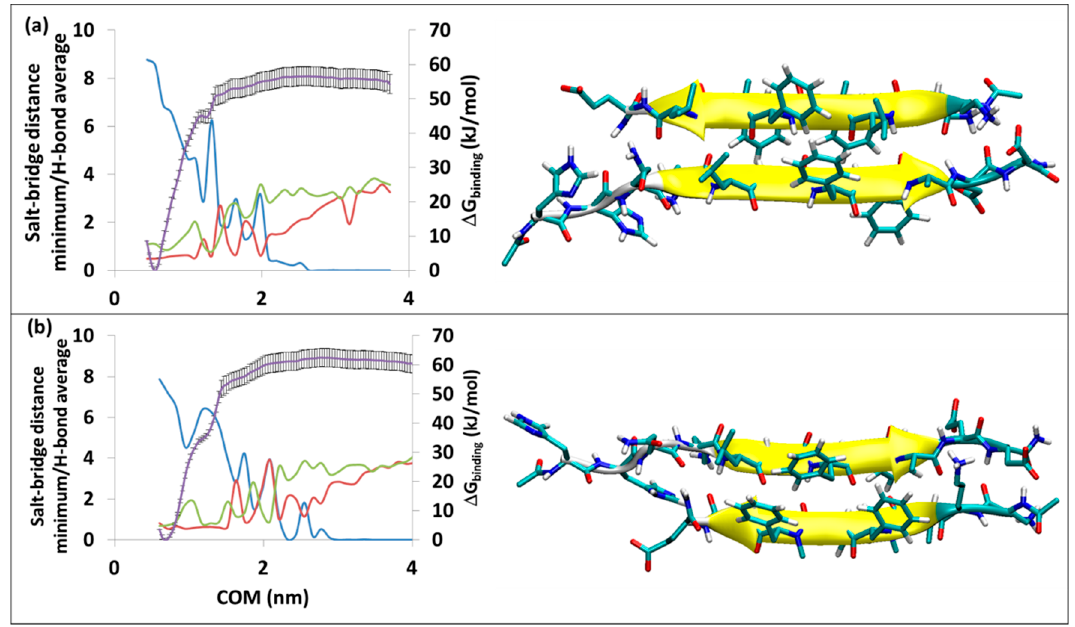
Figure 2. Binding of SGB1 to R at ( a ) R T -SGB1, on the top edge, ( b ) R B -SGB1, on the bottom edge. The right-hand axis is for PMF curve (purple line) in kJ/mol, the error bars are included (±1 σ ). The left-hand axis has two functions: a numerical count of the average intermolecular H-bonds (blue line) and a distance measure in nm for the separations of the polar charged residues (salt-bridges), Lys16-glu8 ′ (green line) and minimum distances for Glu22-daba1 ′ , Glu22-orn2 ′ , Asp23-daba1 ′ , Asp23-orn2 ′ (red line). The horizontal axis is the separation of the centers of mass in nm. Table 1. The registry, population (p i ) and average number of intermolecular hydrogen bonds (H- bond) for the first clusters of R-complexes of pseudo-peptides (the top and bottom edge) and the homodimers, with their corresponding ∆ G dis , from umbrella sampling.